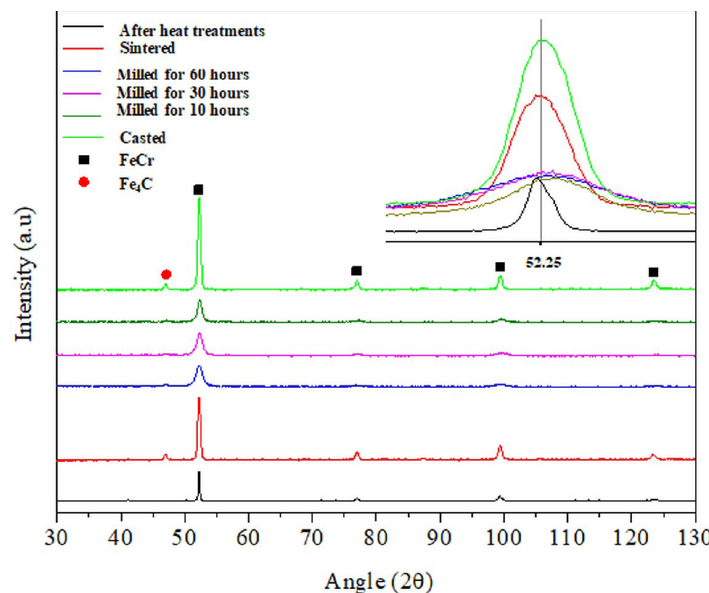
Figure 9. X-ray of the X22CrMoV12-1 alloy before and after